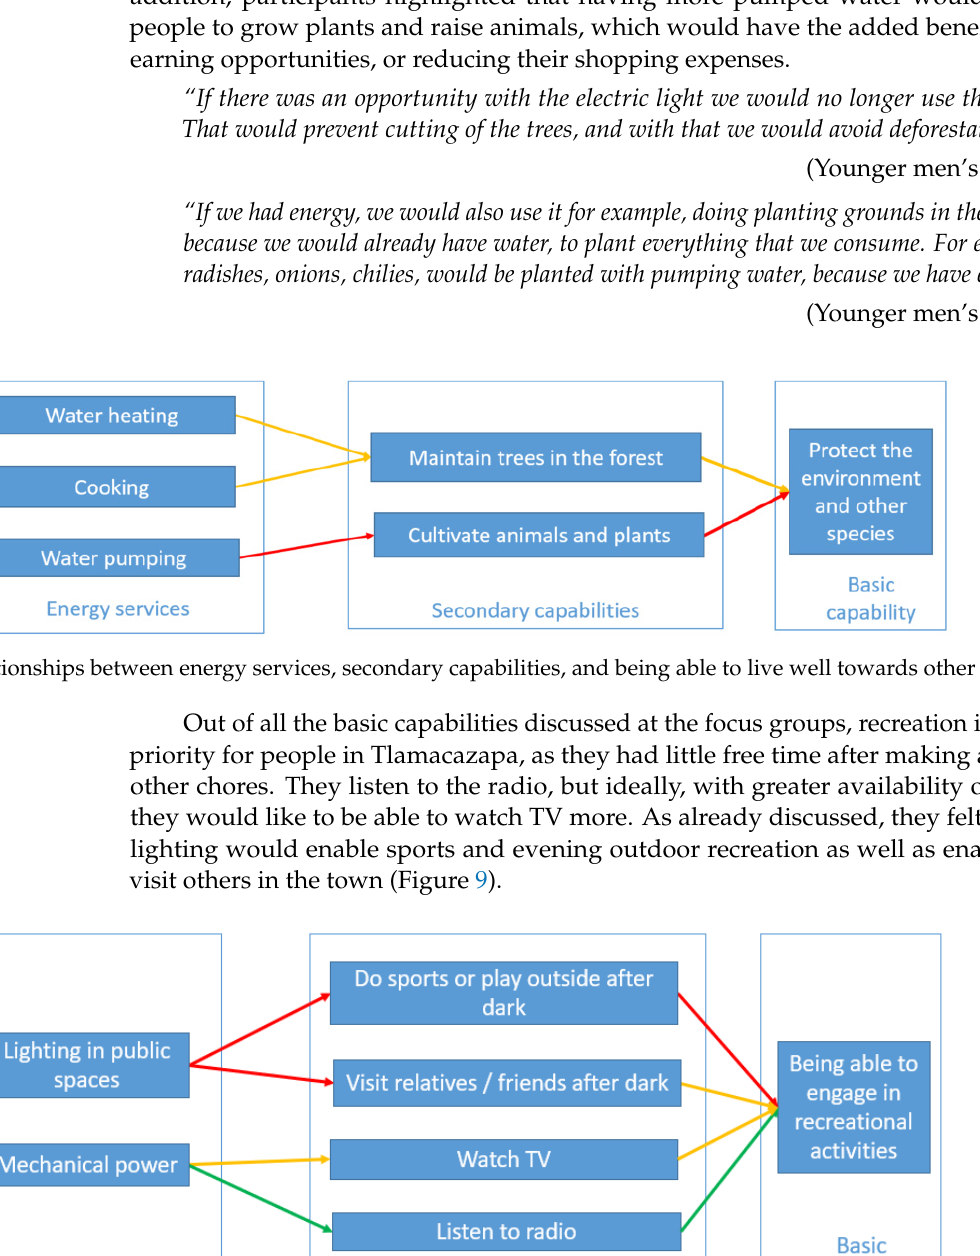
Figure 7. Connections between energy services, secondary capabilities, and ability to maintain dignity and social respect.